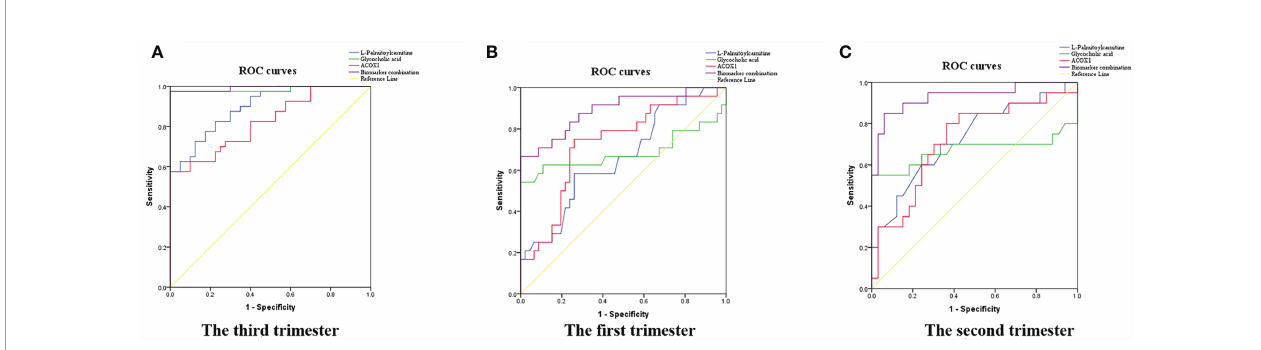
FIGURE 5 | Diagnostic and predictive utility of maternal serum biomarker levels among pregnant women with ICP. (A) Diagnostic value in the third trimester; (B) predictive value in the fi rst trimester; (C) predictive value in the second trimester; the three biomarkers combined resulted in the greatest